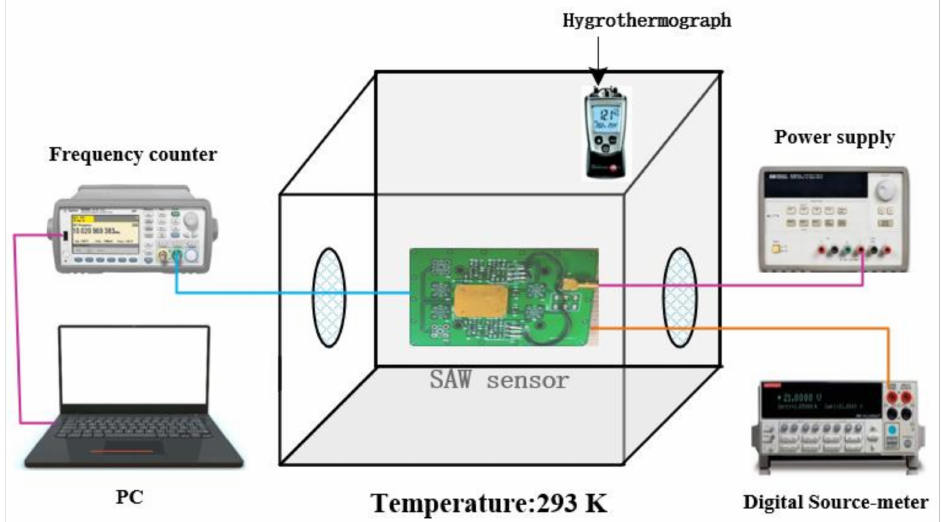
Figure 2. SAW gas sensing test